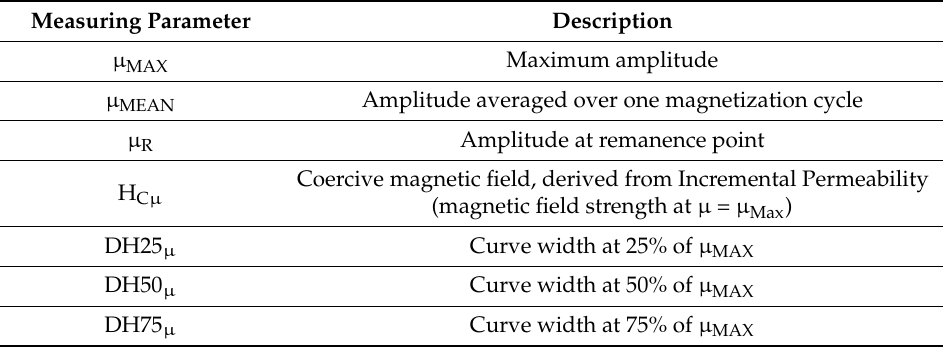
Table 4. Measuring parameters from Incremental Permeability